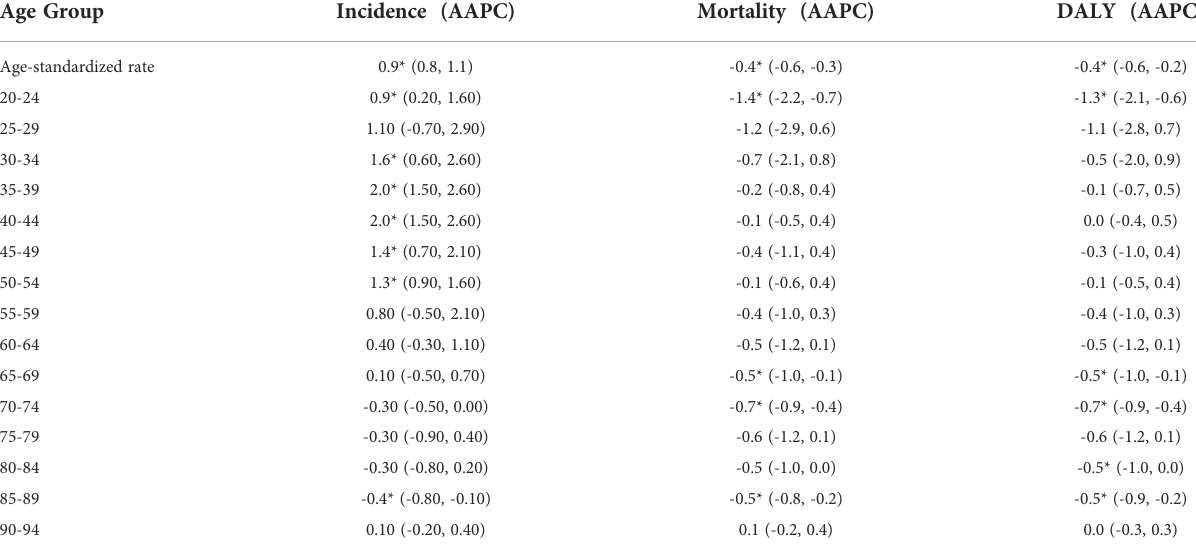
TABLE 2 The average annual percent changes (AAPCs) in age-speci fi c incidence, mortality and DALY rates of cervical cancer in China, 1990 – 2019.